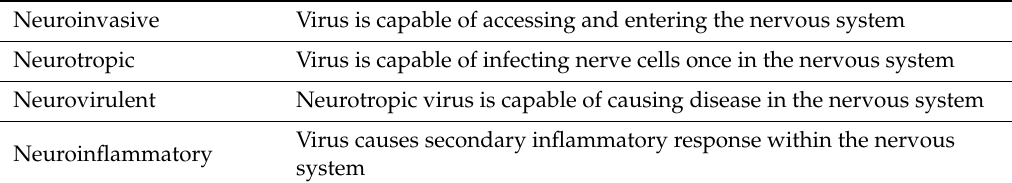
Table 1. Definitions relevant to viral infections of the peripheral and central nervous